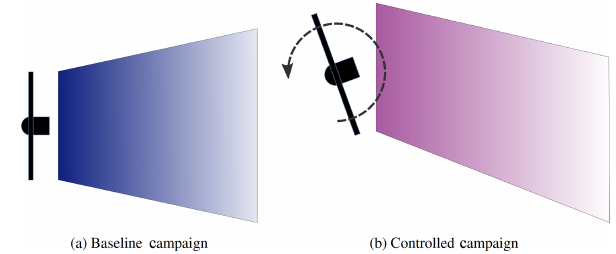
Figure 4. Baseline results (shown in blue throughout this article) are those in which the control turbine operates normally based on the toggle setting in Fig. 3. Controlled operation includes all times when the controller is enabled according to the toggle (regardless of achieved offset); this is shown in magenta throughout this article. Finally, the figure indicates a positive yaw offset that represents a counterclockwise rotation of the turbine viewed from